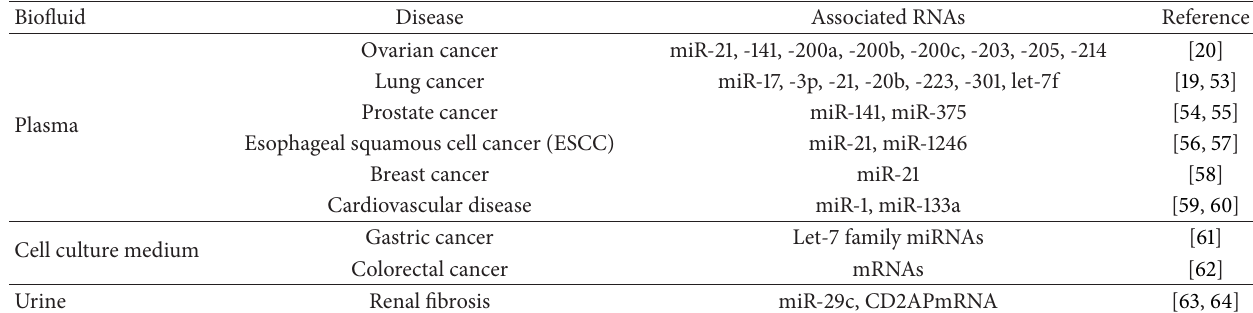
Table 2: Summary of exosomal RNAs for clinical diagnostic